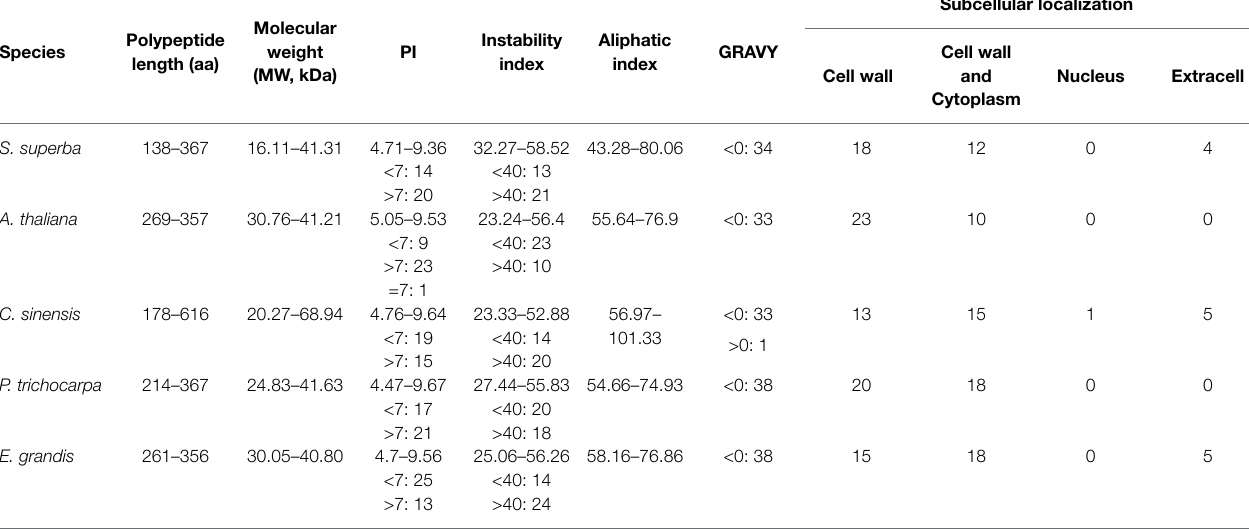
TABLE 1 | Statistics of the physicochemical properties of the XTH gene family in five plant species. Species